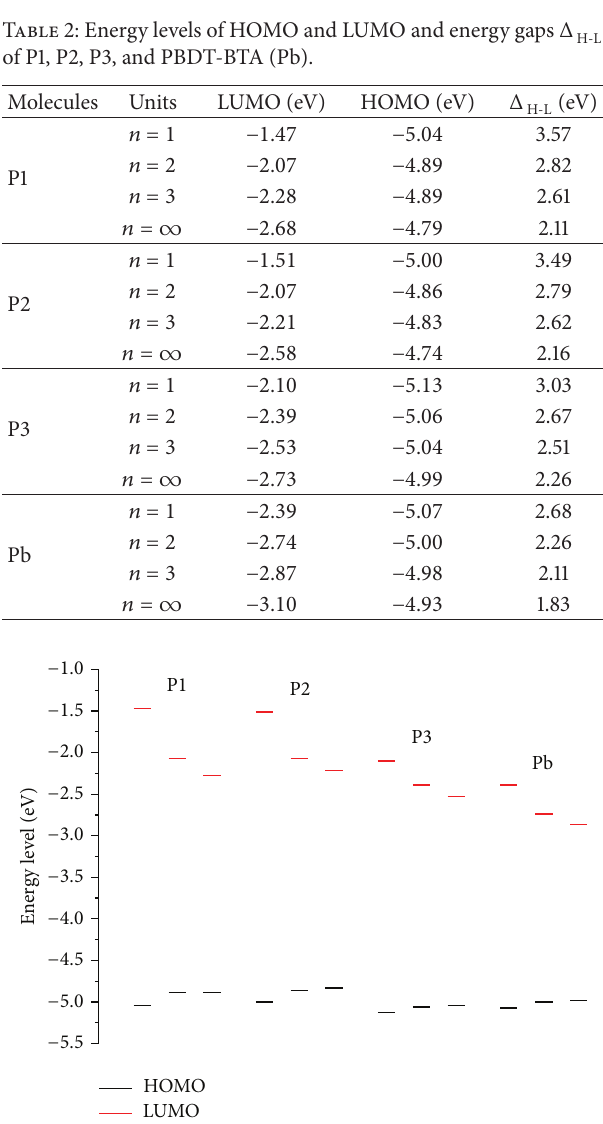
Figure 2: HOMO and LUMO energy levels of the oligomers (𝑛 = 1, 2,3) .